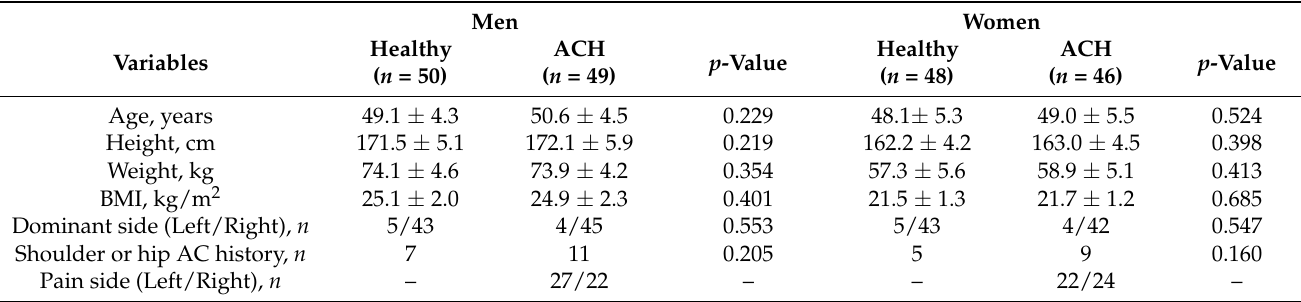
Table 1. General characteristics of participants.